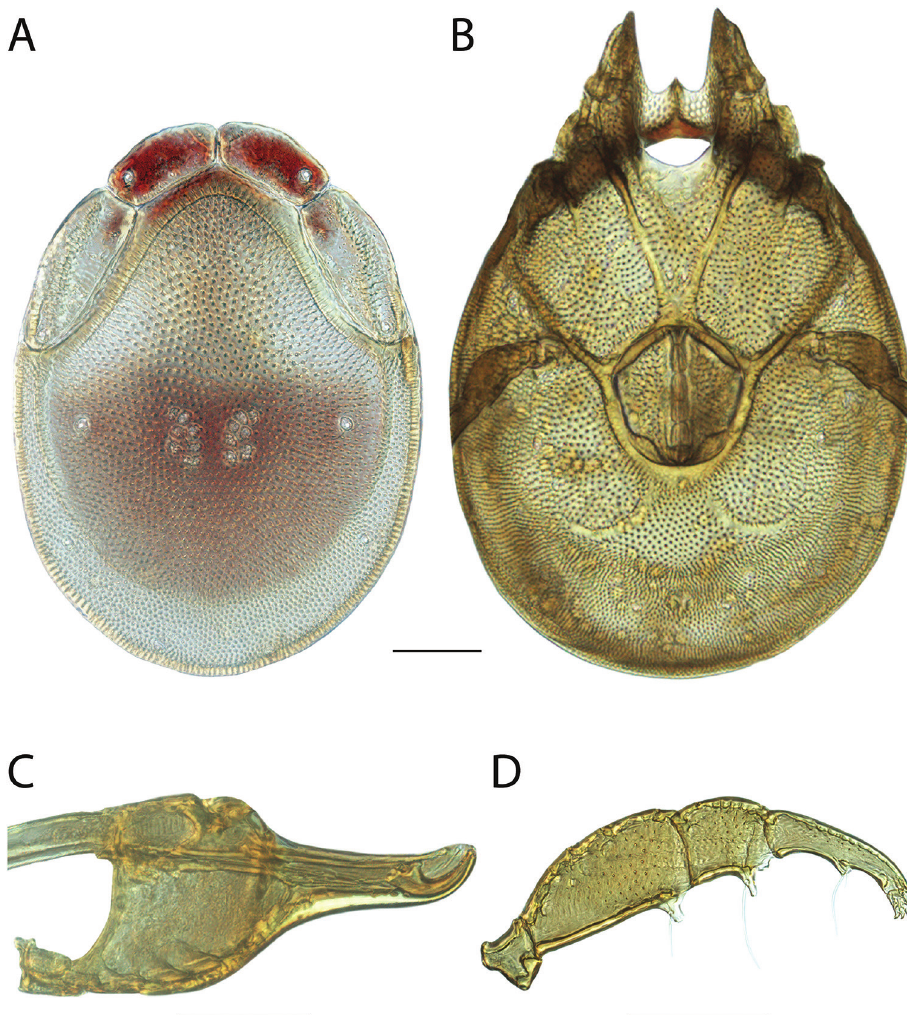
Figure 45. Torrenticola daemon sp. n. female: A dorsal plates B venter (legs removed) C subcapitulum D pedipalp (setae not accurately depicted). Scale = 100